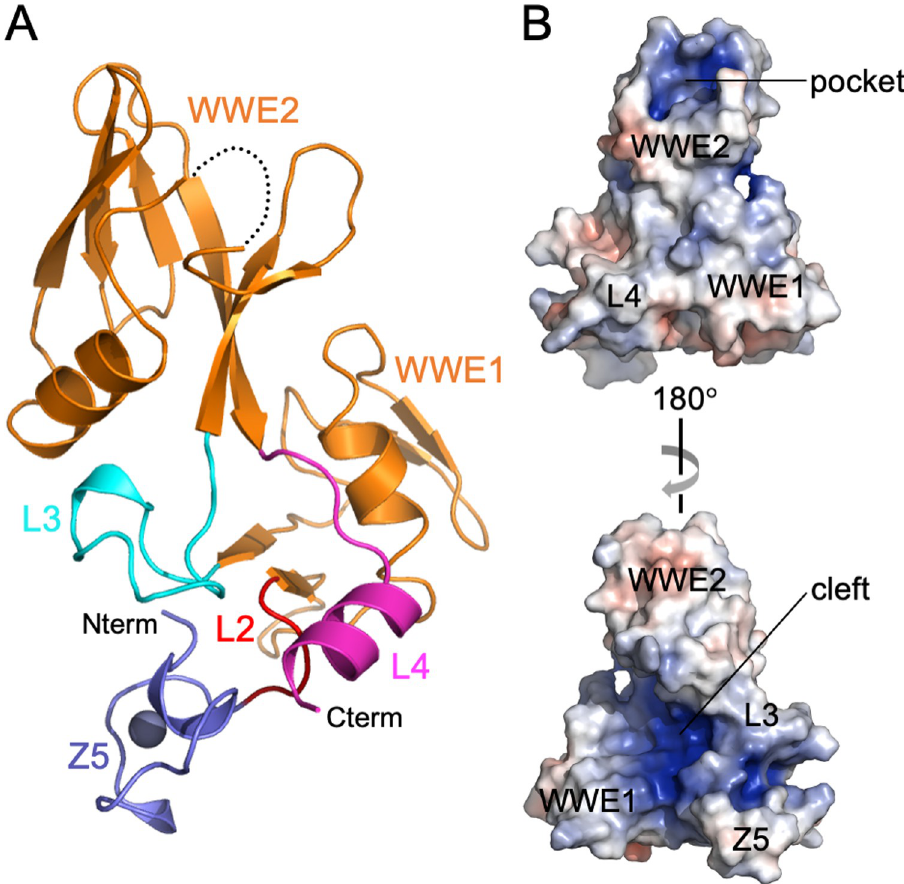
Fig 2. Structure of ZAP-CD. (A) Ribbons representation. Modules are colored according to Fig 1A (Z5 in blue, WWE1 and WWE2 in orange), as are the linkers (L2 in red, L3 in cyan, and L4 in magenta). The amino and carboxyl termini are also indicated. Black dashes denote a flexible loop in the second WWE module with very weak density and left unmodeled. (B) Orthogonal surface views colored according to electrostatic potential from red (negative) to blue (positive). The Z5, WWE1 and WWE2 modules are indicated, as are the putative isoADPr pocket (top) and the extended electropositive cleft (bottom).